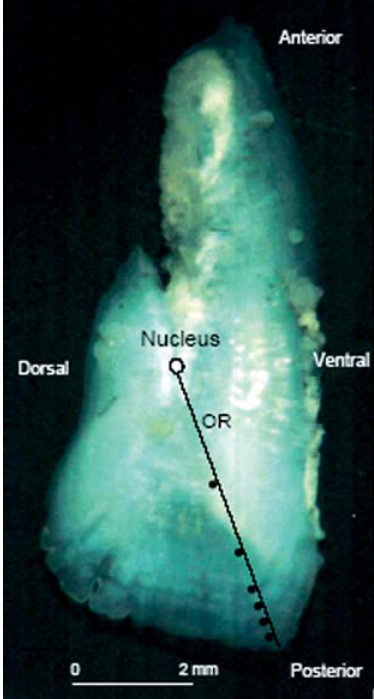
Fig. 2. Characteristics of whole otoliths from Scomberomorus brasiliensis observed under transmitted light for age determination. Female specimen, six years of age, measuring 57 cm FL (OR = otolith radius; = translucent